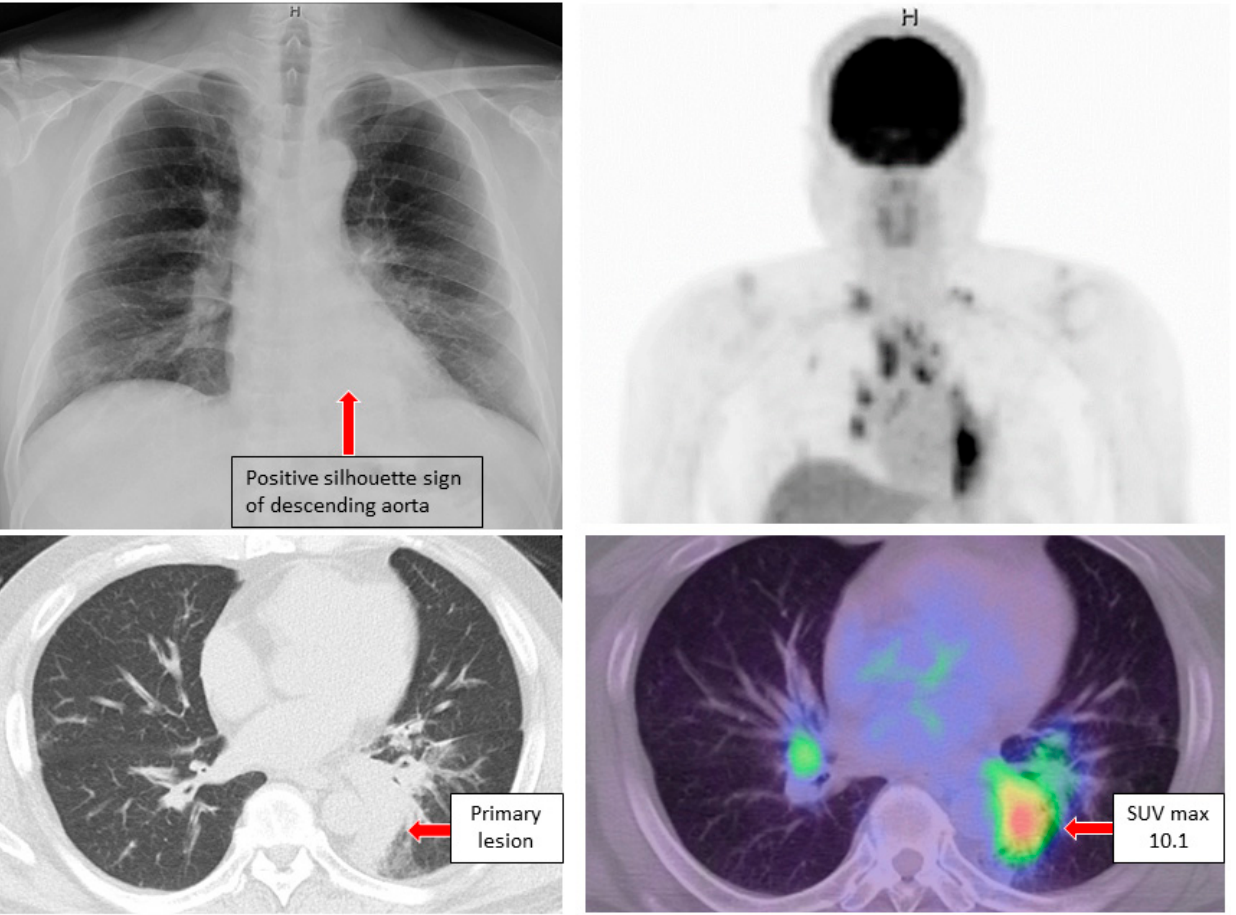
Figure 2. Chest X-ray, CT and FDG-PET examinations in case 1 revealed primary lung cancer at the left lower lobe (red arrow) and multiple lymph node metastases. CT: computed tomography, FDG-PET: 18F-2-fluoro-2-deoxy-D-glucose-positron emission tomography.